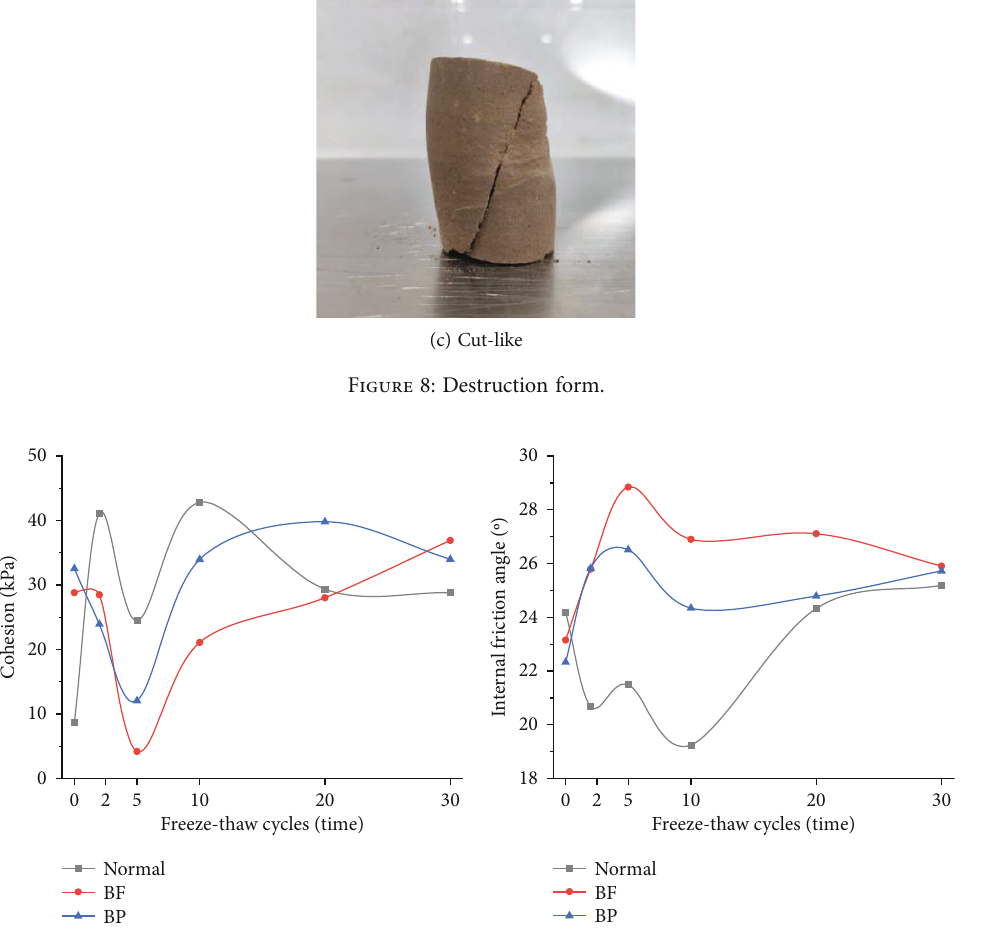
Figure 9: Cohesion and internal friction